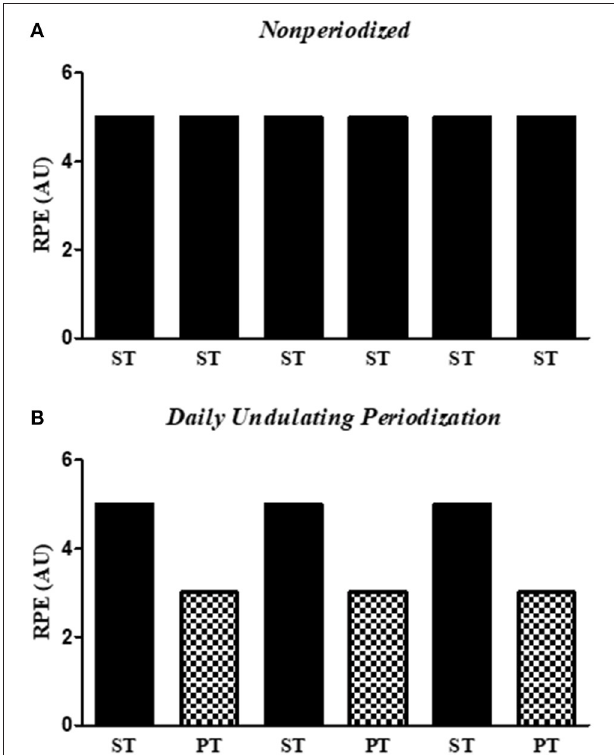
FIGURE 2 | Training load distribution in the Non-periodized (A) and Daily undulating periodization (B) programs over 3 weeks. It is possible to observe that the training load remains constant across the non-periodized program, while it is distributed according to a wave shape in the daily undulating periodization program. RPE, Rating of perceived exertion; AU, Arbitrary units; PT, Power training; ST, Strength